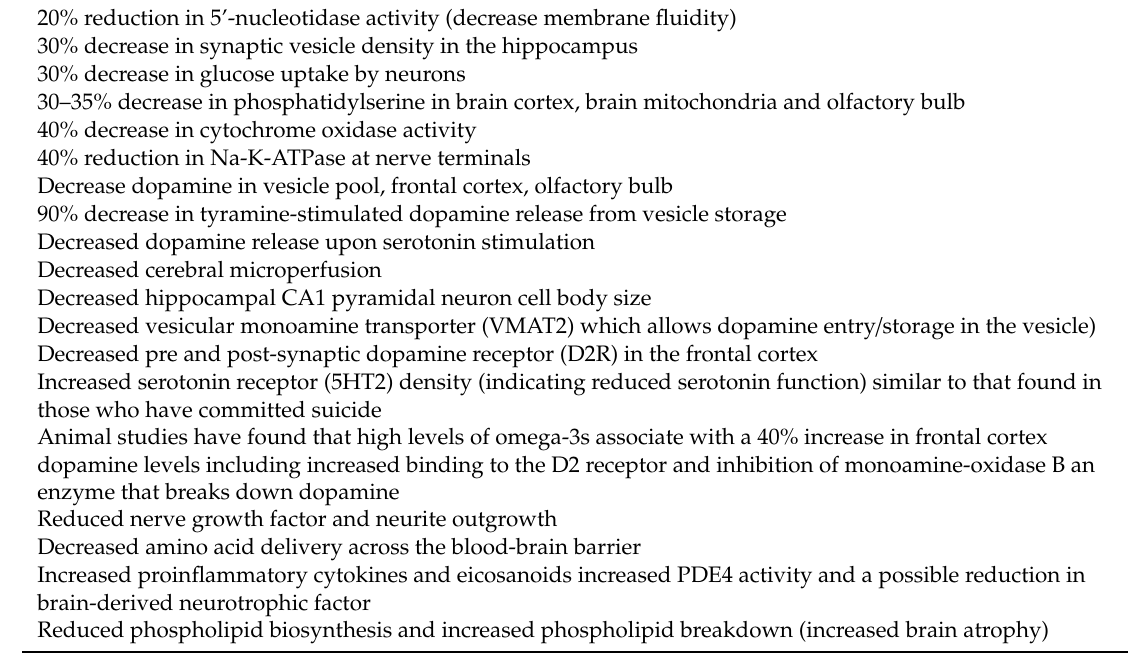
Table 1. Consequences of having a long-chain omega-3 fatty acid deficiency in the brain (adapted from Logan) [63].